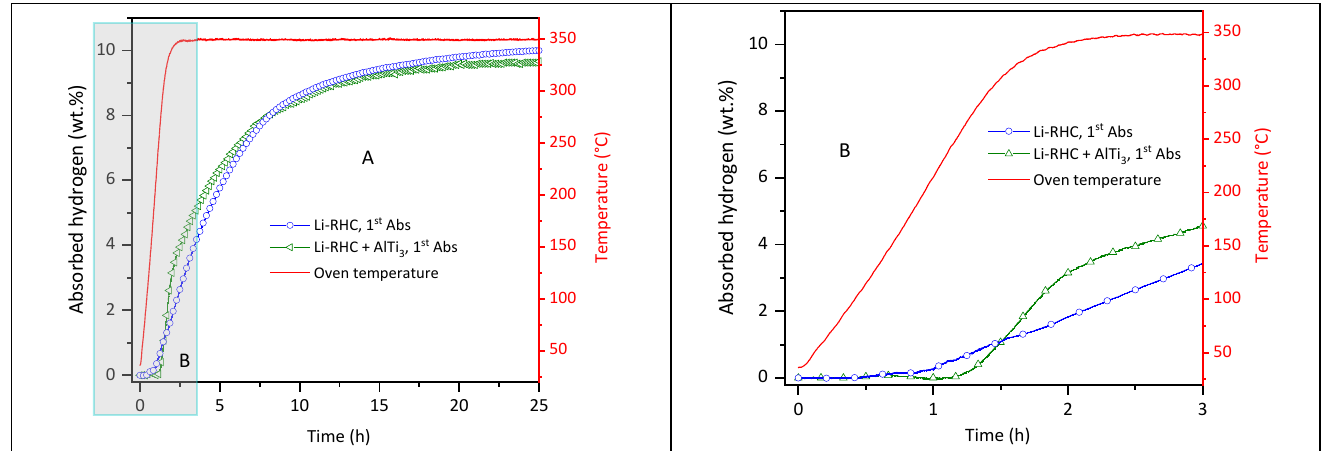
Figure 4. ( A ) The first hydrogenation reaction of the Li-RHC composites with and without additive, measured from RT to 350 °C, under 50 bar of hydrogen pressure, and ( B ) magnification of first few hours of hydrogenation of all investigated samples presented in ( A ).